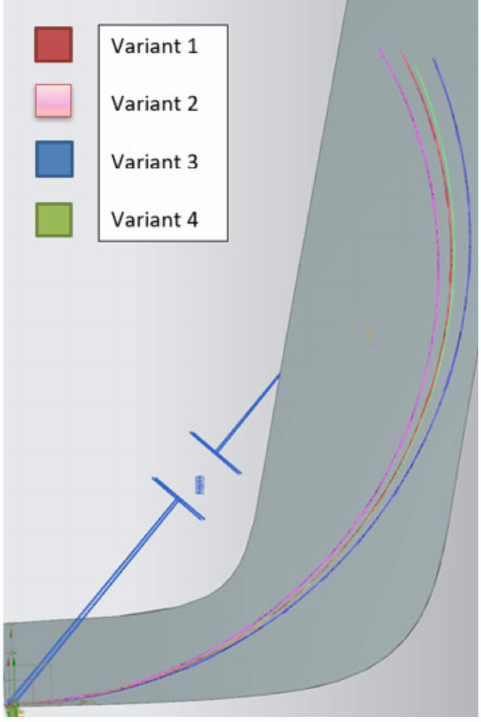
Figure 9. Comparison of the trajectory with different variants of PLA-TPU bushings.